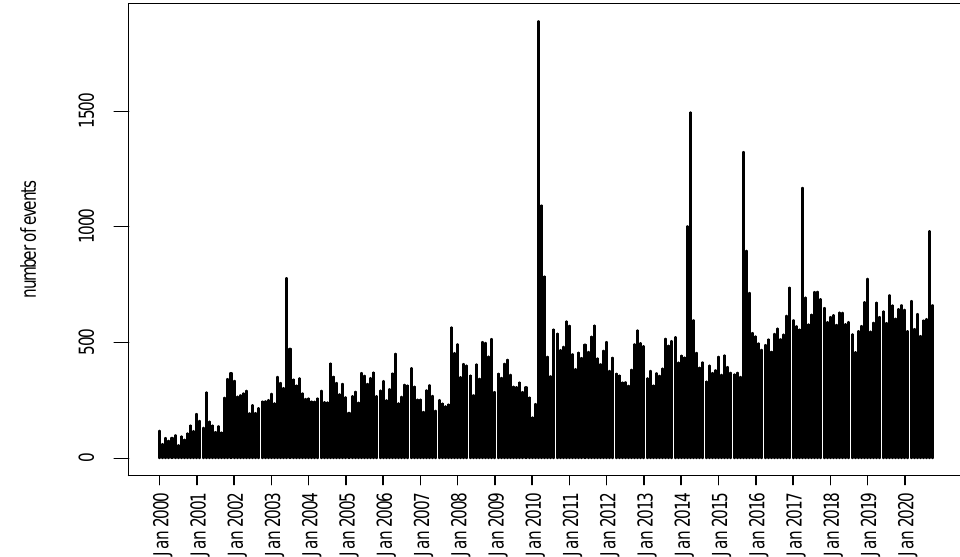
Figure 1. Distribution of number of events by month in Chile.